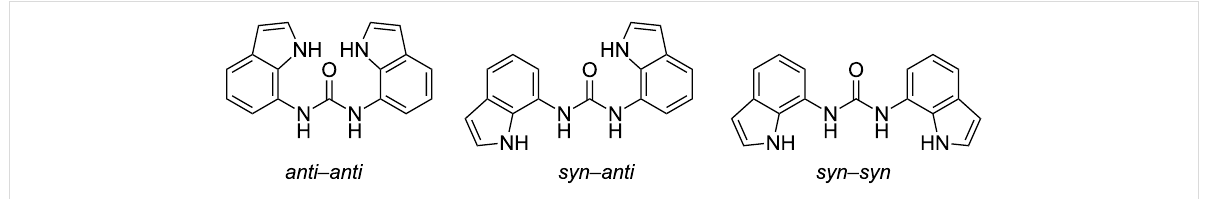
Figure 3: Three representative conformational families of rotamers of 1 . Notations refer to the orientations along [C6–C7–N7 α –C7 β ] fragments.